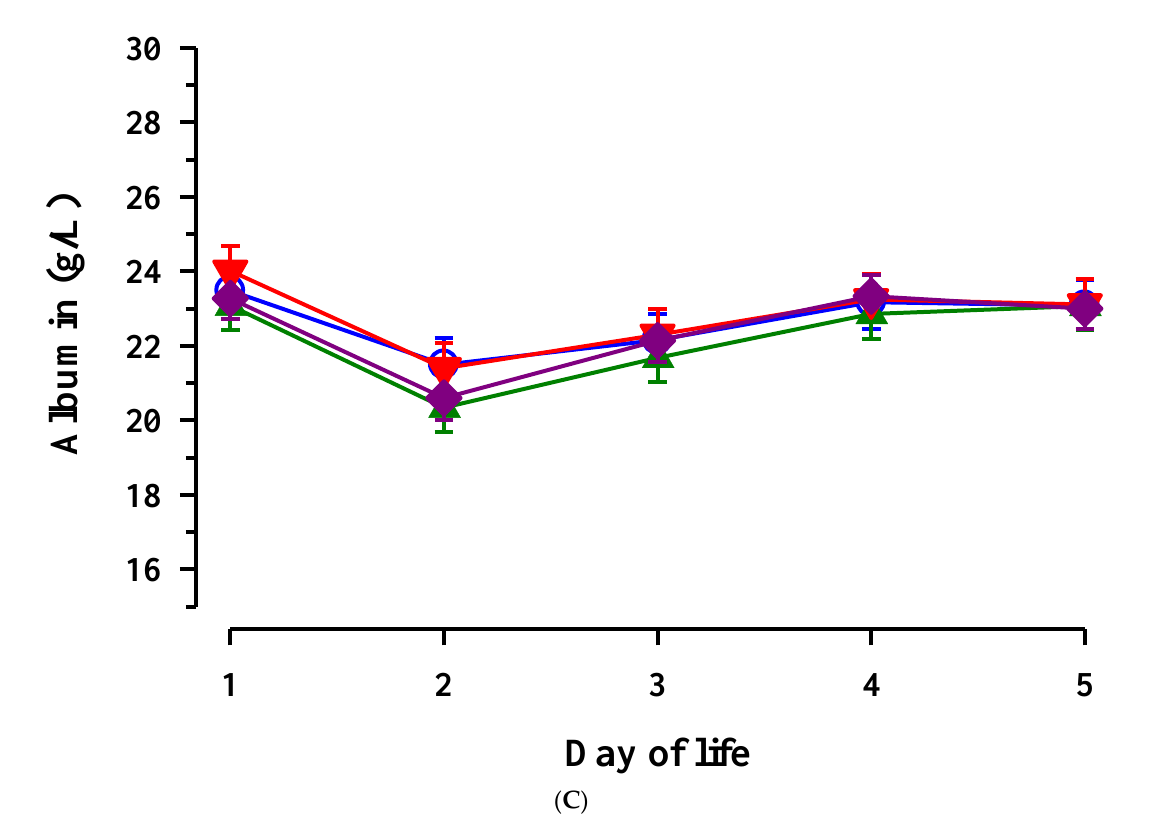
Figure 2. Plasma immunoglobulin G ( A ), total protein ( B ) and albumin ( C ) concentrations in calves dependent on maternal fatty acid supplementation ( ○ control, CON n = 9; ▲ EFA, essential fatty acids, n = 9; ▼ , CLA, conjugated linoleic acid, n = 9; ♦ , EFA + CLA, n = 10) and time after birth. Day 1 corresponded to the day of birth. ab Different superscripts mark significant differences between groups at similar time points ( p < 0.05). Y between calves with and without maternal CLA supplementation ( p <